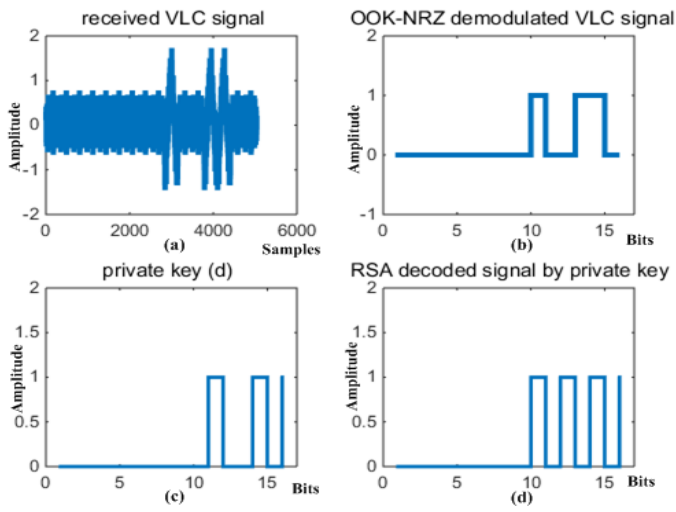
Figure 6. Signal waveforms of major functions in proposed VL transmitter of Figure 2a.